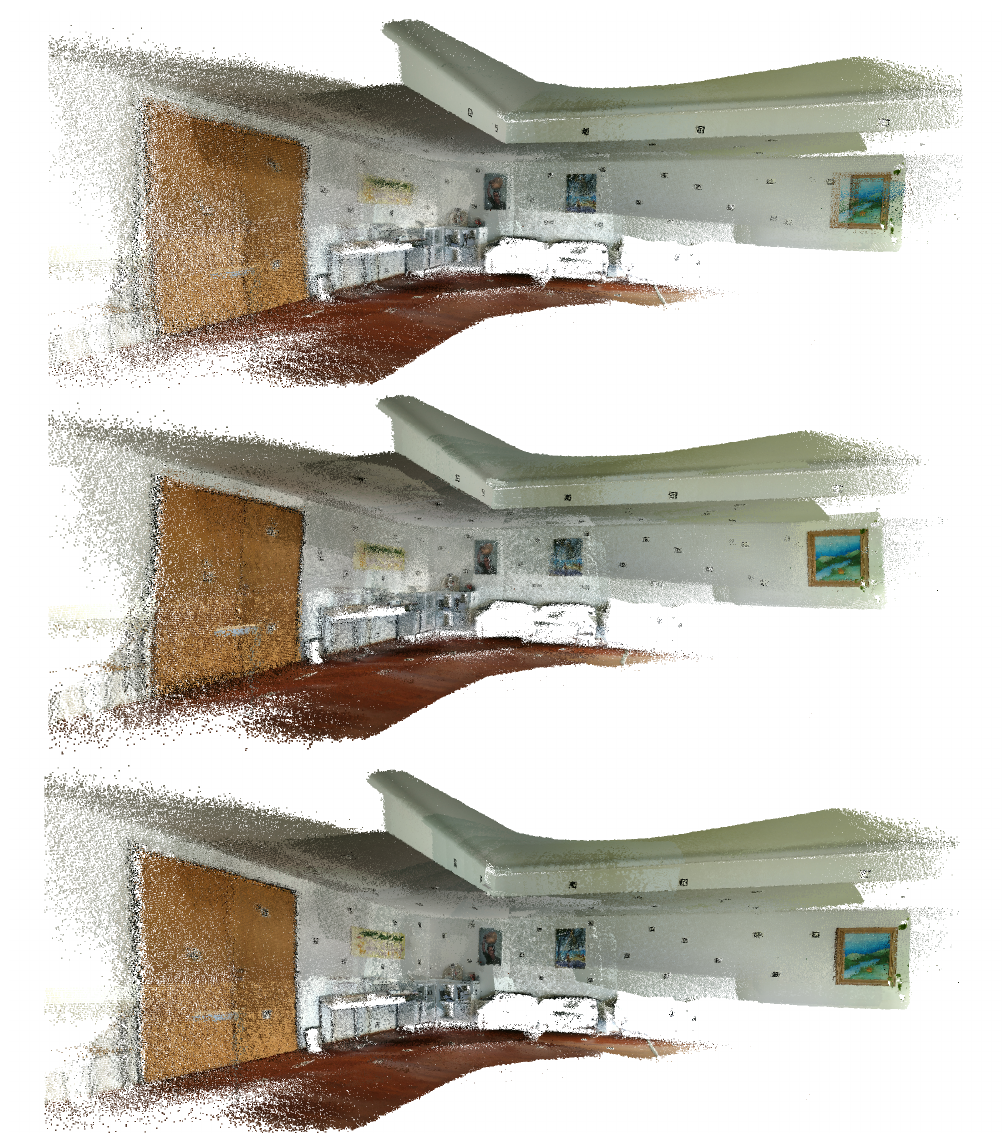
Figure 19. MeetingRoom dataset coloured with texture obtained from original images: ( top ) Google Tango; ( middle ) Iterative Closest Point (ICP); ( bottom ) Our